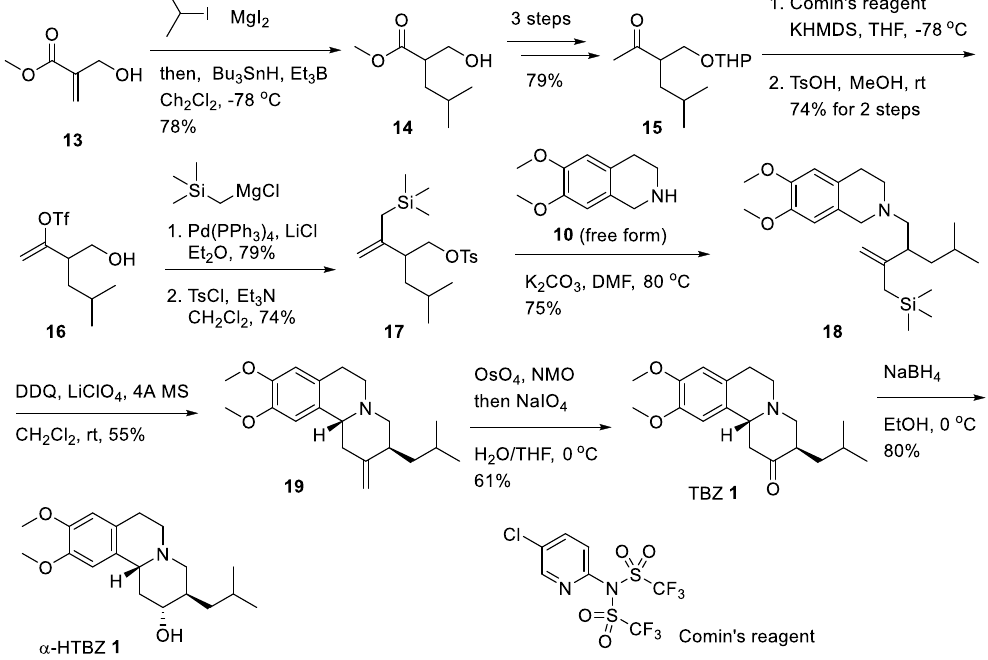
Scheme3. SynthesisofTBZusinganaza-Prins-typecyclizationreaction. THP:Tetrahydropyran;